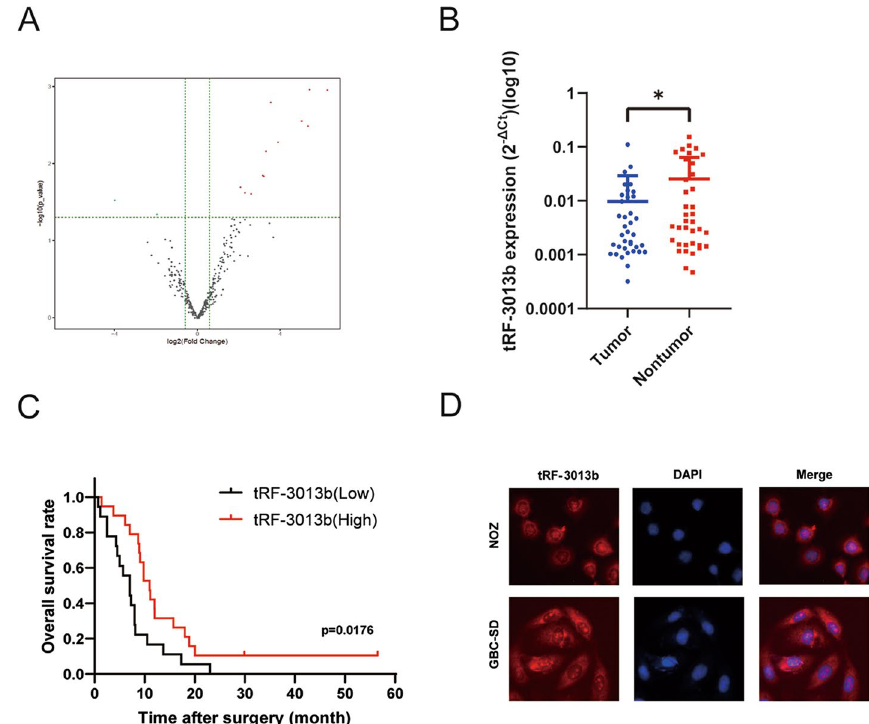
Fig. 1 tRF-3013b was significantly downregulated in GBC and correlated with prognosis. A Volcano plot of tRF and tiRNA. Green/red circles indicate differentially expressed tRFs and tiRNAs with fold change no less than 1.5 and P 0.05 (green: downregulated; red: upregulated). B tRF-3013b expression level in 37 pairs of ≤ GBC and para-cancer tissues. C Overall survival of GBC patients with high or low tRF-3013b expression. D Location of tRF-3013b in NOZ and GBC-SD cells detected by FISH. * P < 0.05